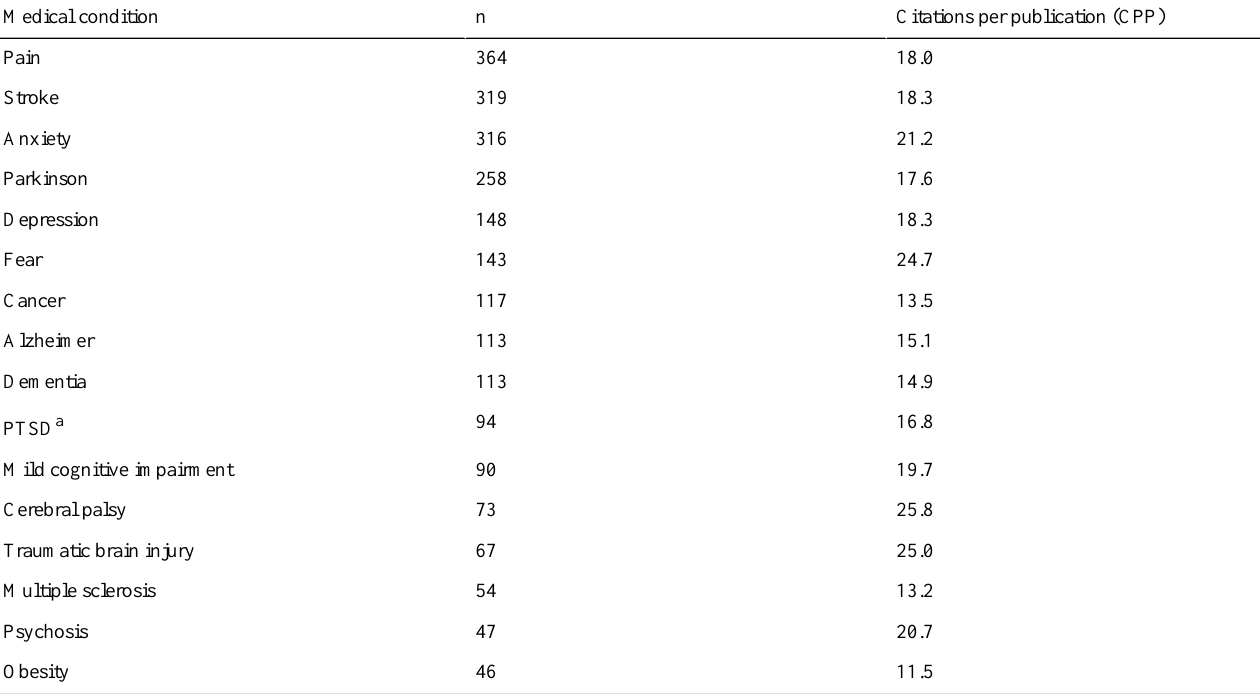
Table 5. Medical conditions mentioned in at least 0.5% (42/8399) of the publications of virtual reality research in